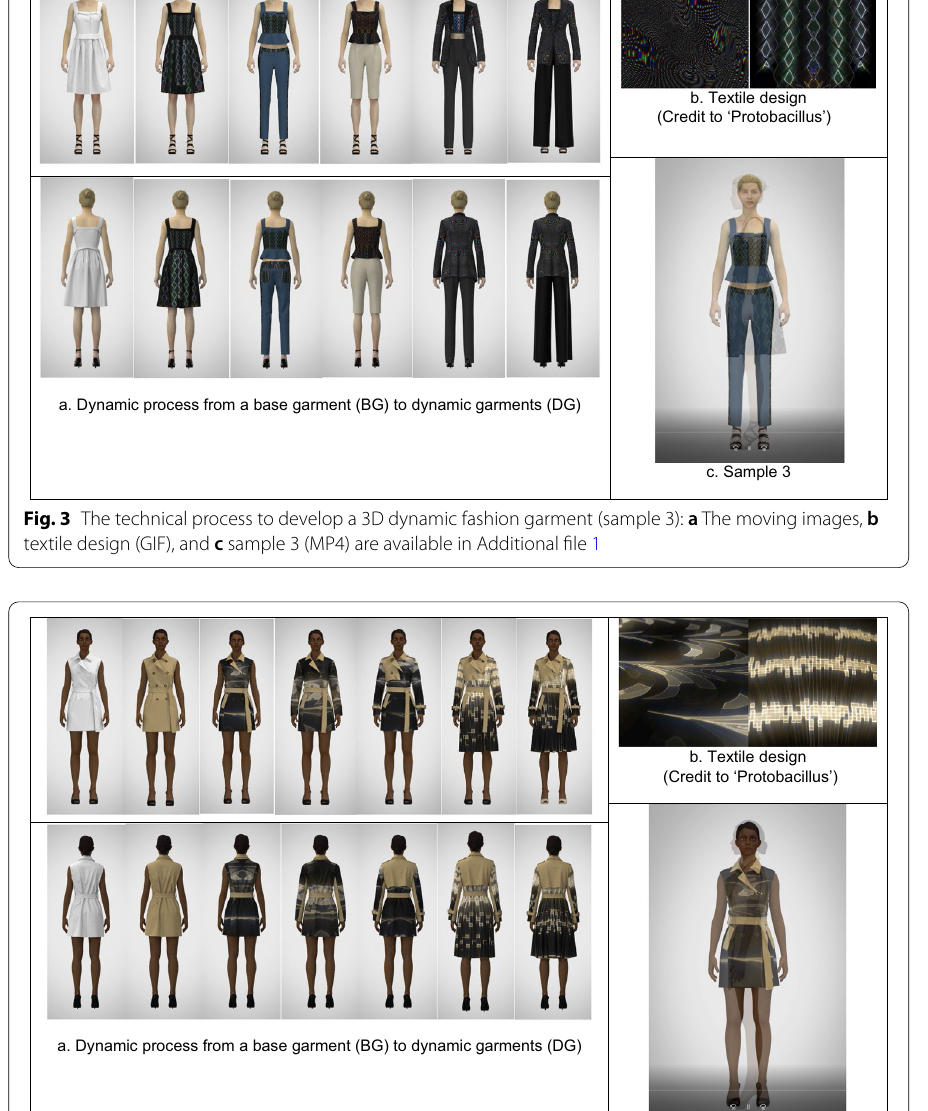
of Aftereffects, and eventually became a 3D dynamic fashion garment, which repre- sented transformative forms and details, color changes, and sequential fabric images.